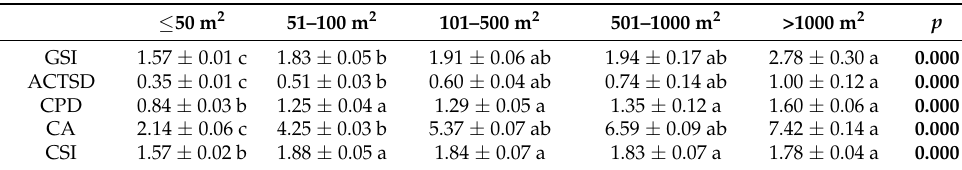
Table 1. Differences of gap characteristics, color-leaved tree species diversity, color-leaved patch structure attributes in five gap size